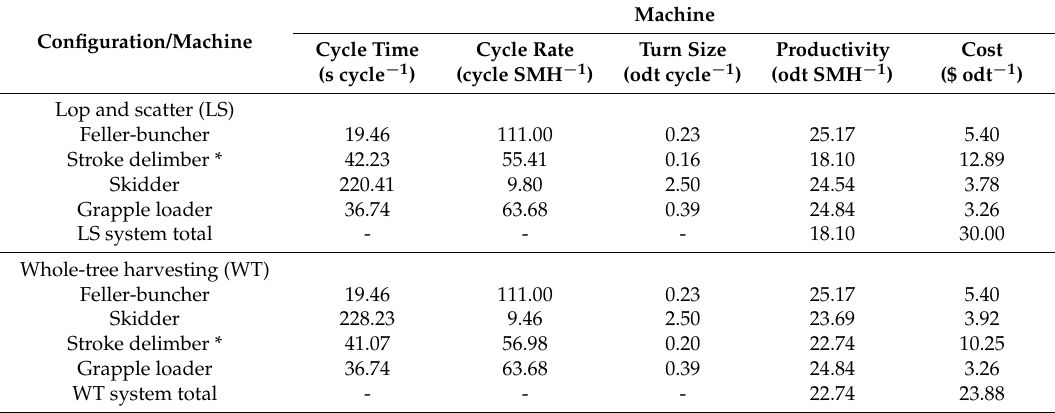
Table 7. Productivity and costs of the lop and scatter (LS), and whole-tree harvesting (WT) methods.